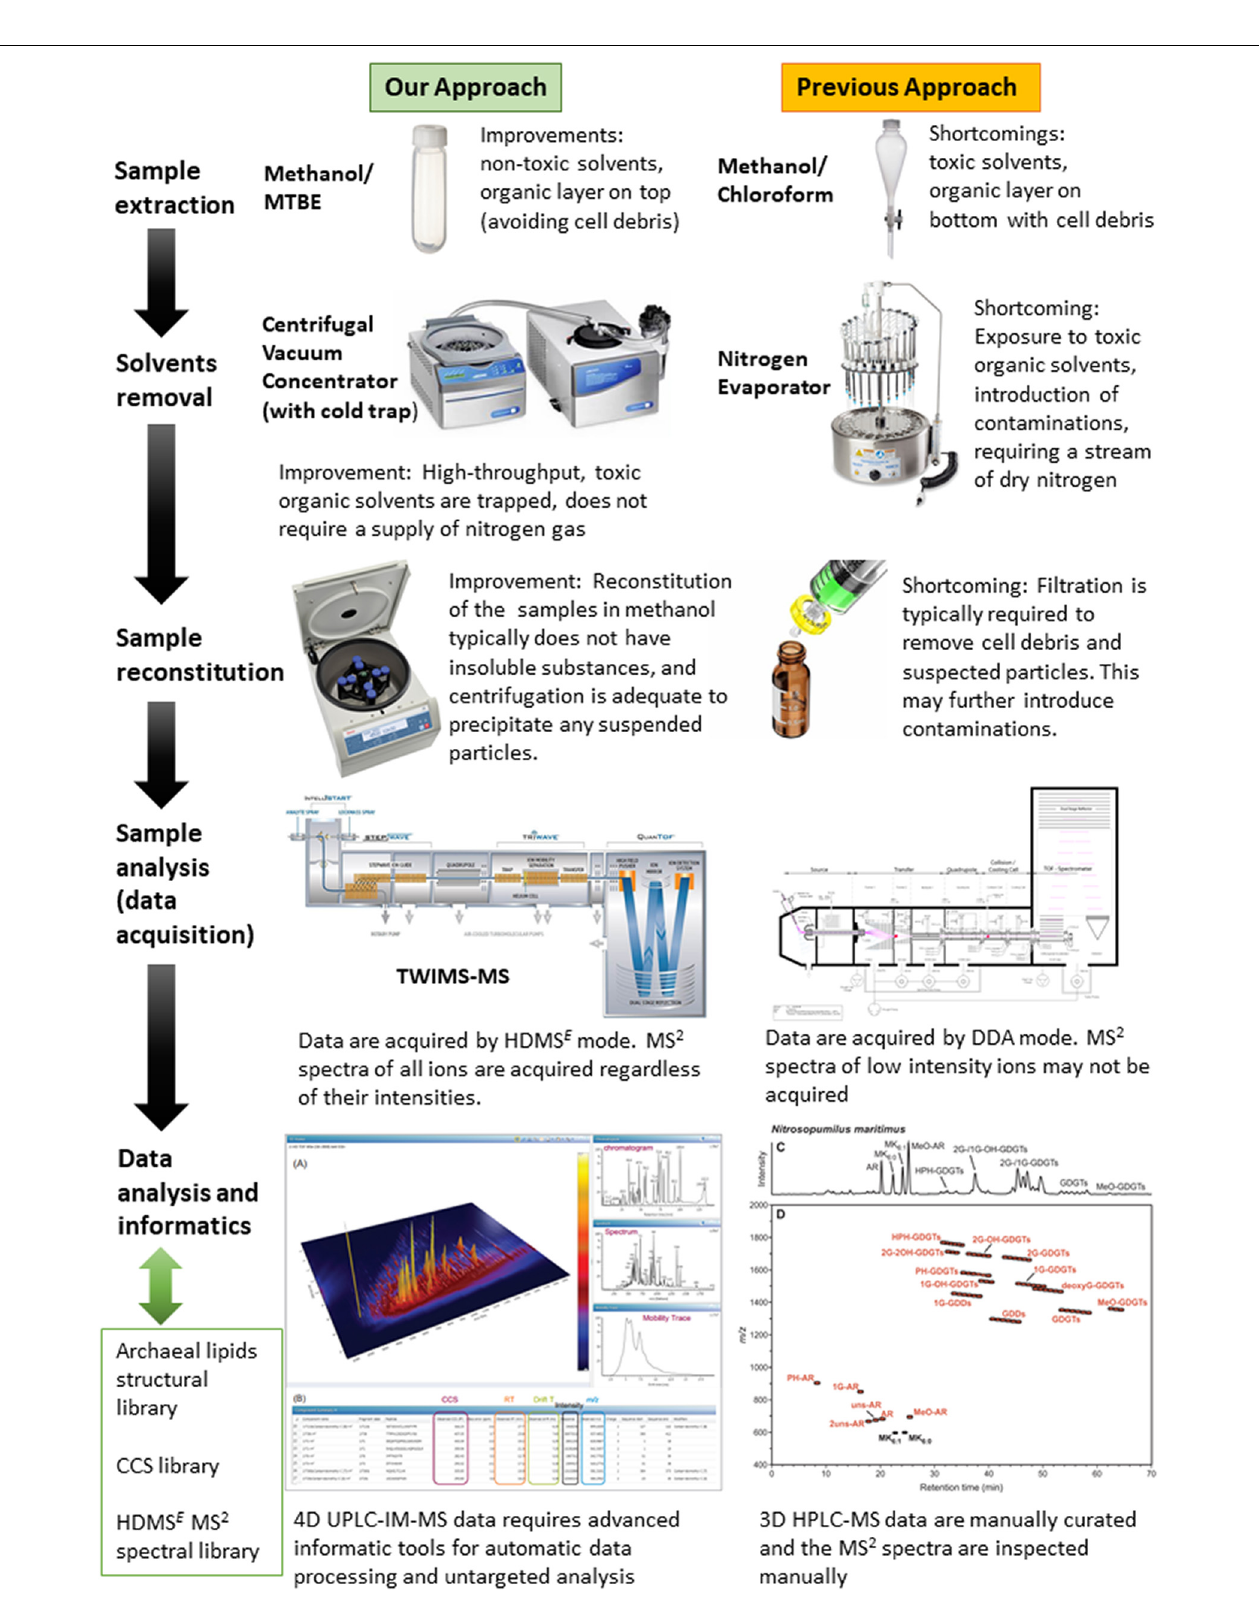
FIGURE 2 | The enhancements brought by the UPLC-IM-MS protocol developed in this work in comparison to the protocol used in previous studies. The panel in the lower right corner is reproduced from Elling et al. (2016).